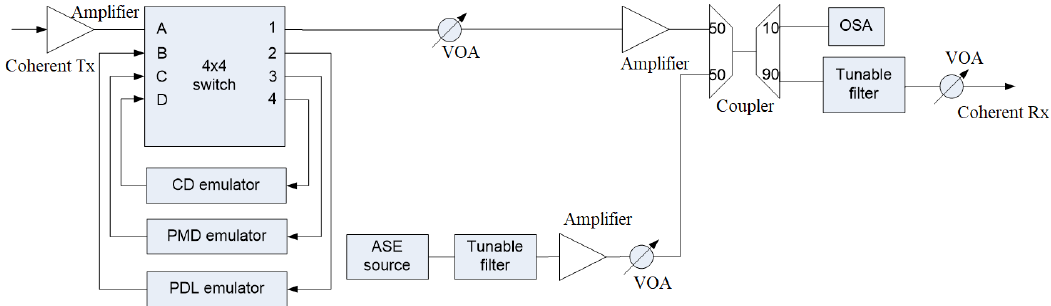
Figure 2. Experimental setup to emulate the bandwidth narrowing effect together with other impairments during the transmission. VOA: variable optical attenuator, OSA: optical spectrum analyzer.